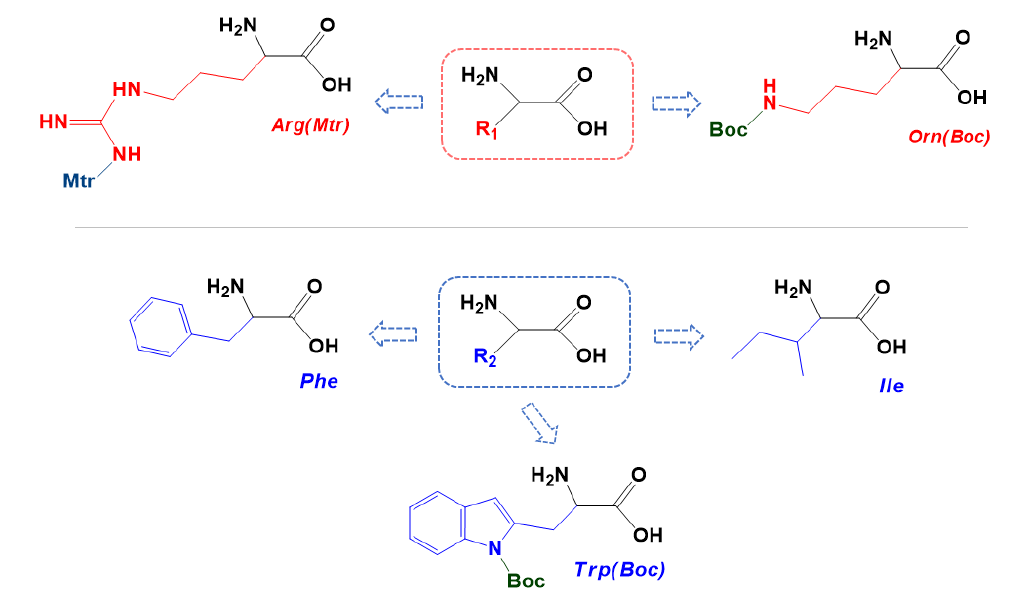
Figure 2. Scheme of the synthesis of amphiphilic copolymers by the post-polymerization modification of poly( α -glutamic acid) and structures of amino acid derivatives used for modification: R 1 (red moiety) indicates a basic amino acid, R 2 (blue moiety) indicates a hydrophobic amino acid.